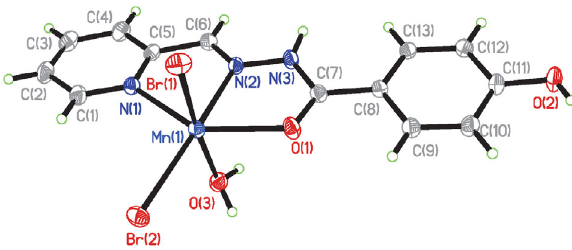
Figure 1. ORTEP diagram of complex 1 (30% thermal ellipsoid).